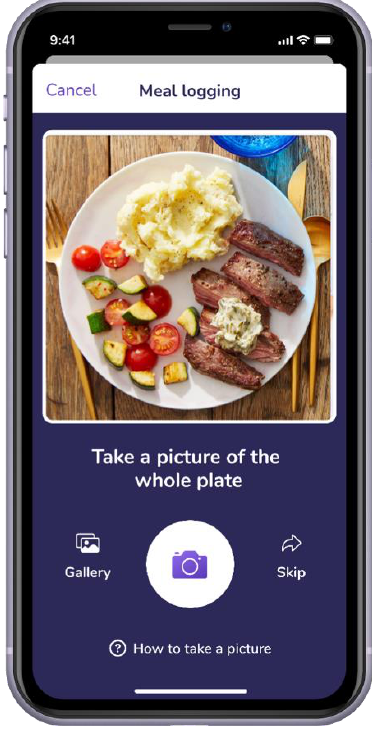
Figure A2. In-app meal-logging function.